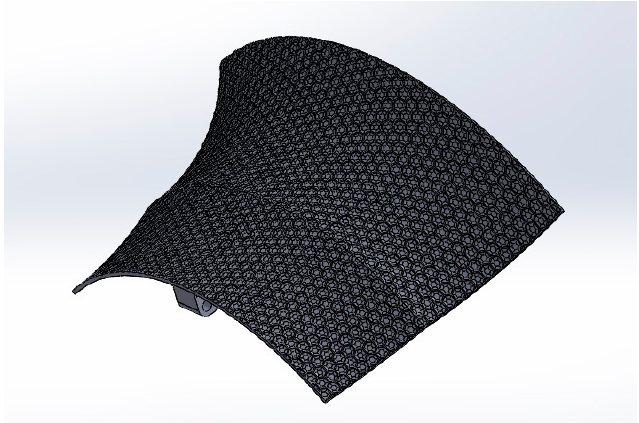
Figure 17. View of the reflector model with a diffusing macrostructure.